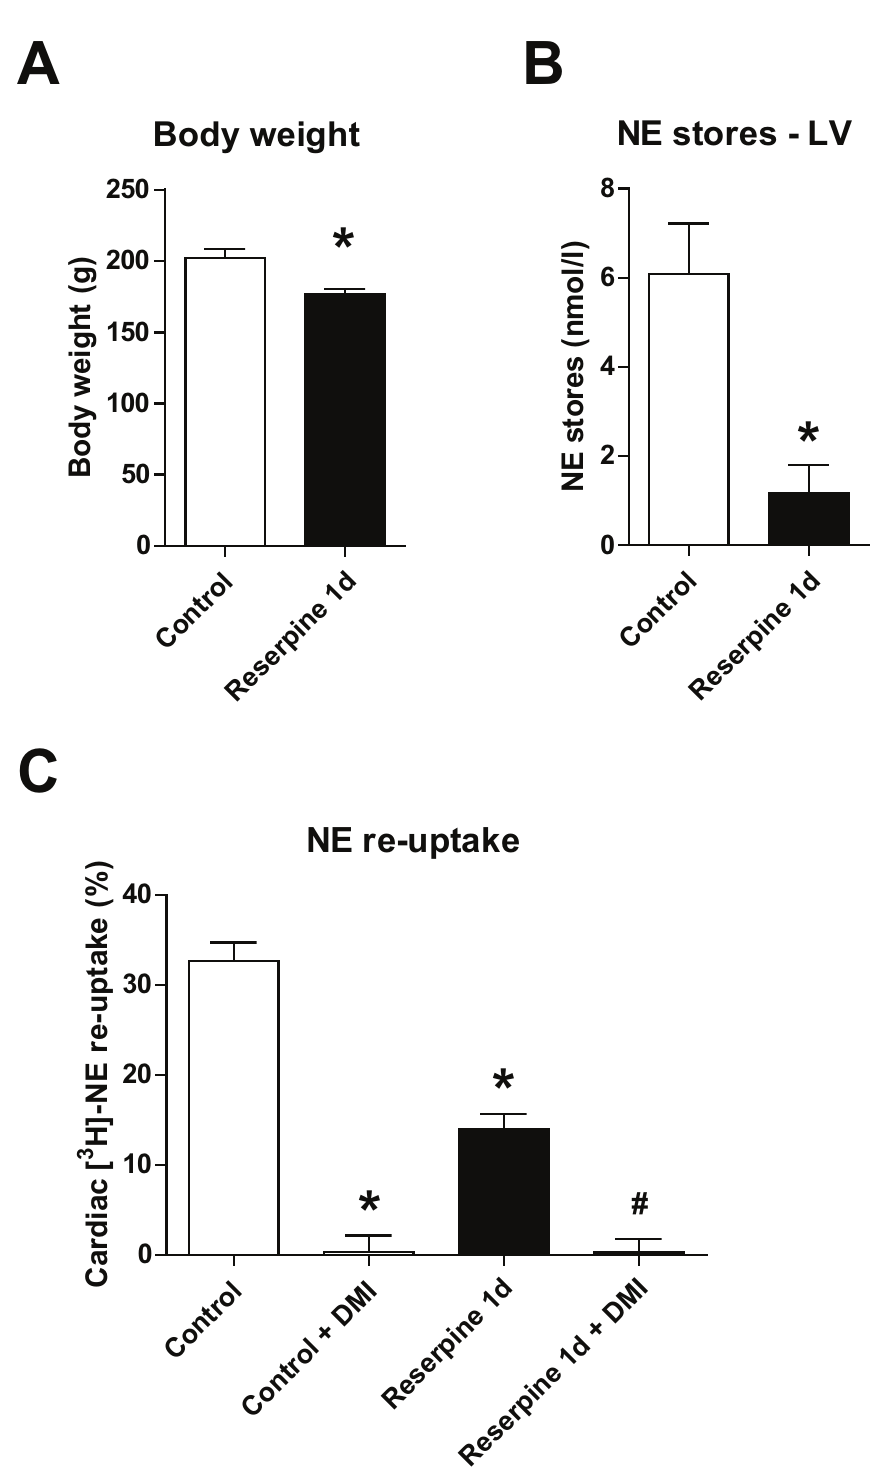
Fig 2. Cardiac norepinephrine (NE) stores and NE re-uptake at day (1d) of reserpinetreatment. (A) Body weight and (B) left ventricular (LV) NE content after reserpine (5 mg/kg) or saline (control) treatment (n = 6 per group). (C) Cardiac [ 3 H]-NE uptake in the absenceor presenceof desipramine (DMI 1 μ mol/l)after one day of reserpinetreatment comparedto saline-treated controls (n = 6 per group). * p < 0.05vs. control, # p < 0.05 vs.